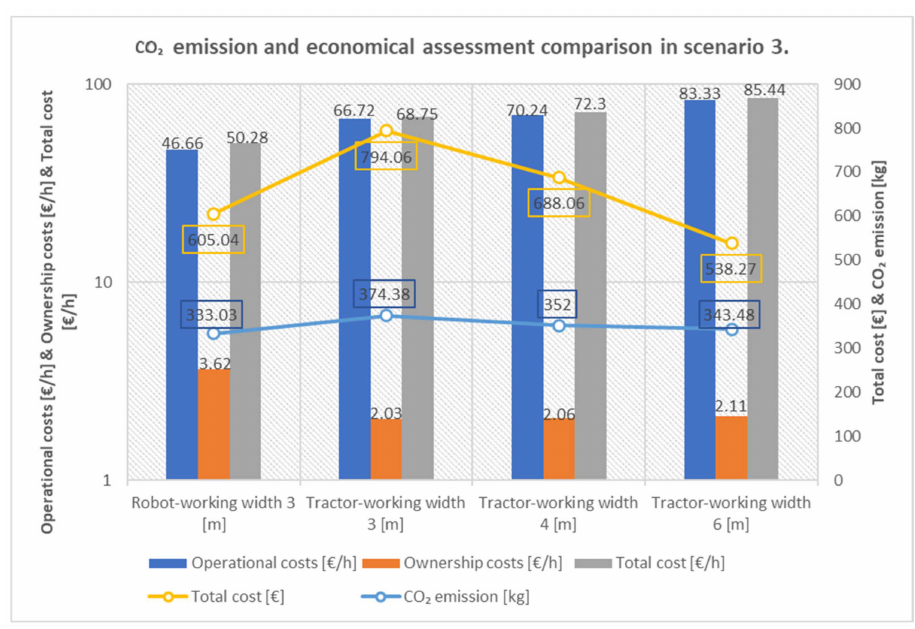
Figure 20. The comparison of economical assessment and CO 2 emission between robot and tractor in the third scenario.